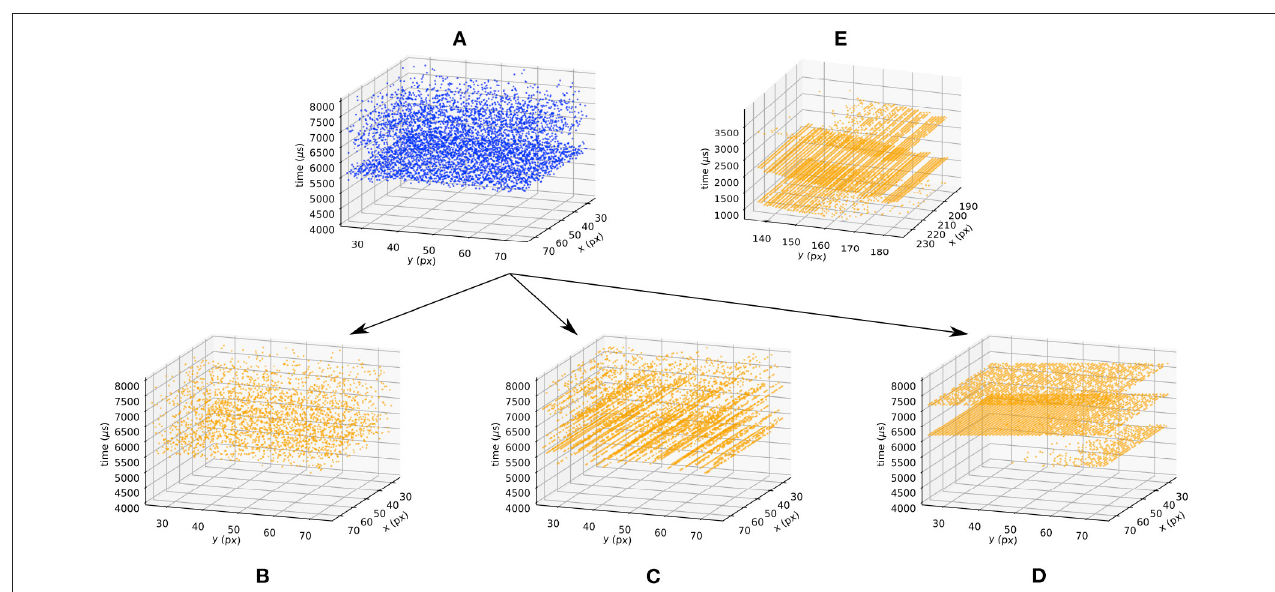
FIGURE 6 | Effect of the arbiter when the background light is flashing. Blue (orange) events correspond to a sensor without (with) an arbiter. The blue events (A) are generated using the ICNS model when the light is turned on at t 5,000. The bottleneck arbiter (B) , asynchronous (C) , and synchronous (D) row models are applied = to the blue events. The data provided by real DVS pixels are provided (E) as a matter of